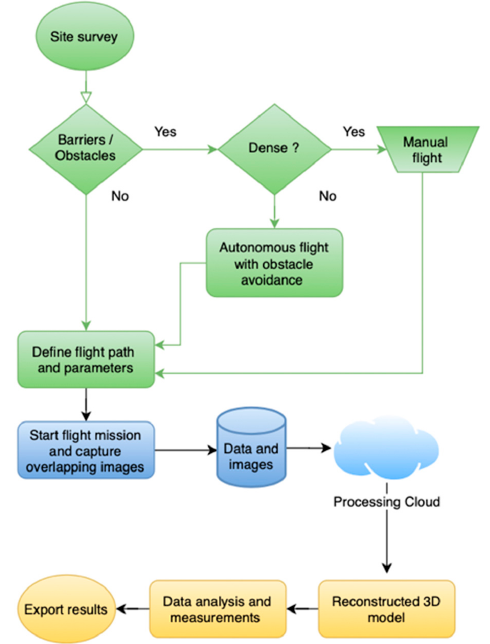
Figure 2. Flowchart of small unmanned aerial vehicle (sUAV) photogrammetry in traffic accident